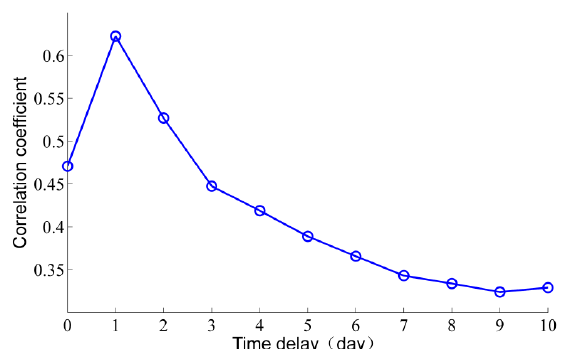
Figure 2. Correlation coefficients of the daily precipitation and streamflow series under different time delays.